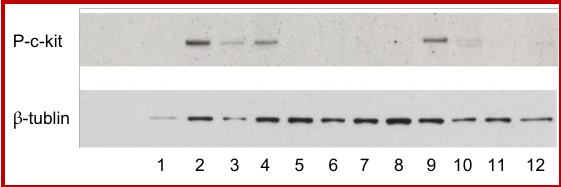
Figure 2: Imatinib inhibits the SCF induced c-kit phosphoryla- tion in NHEM (western blot assay). 1: Control group; 2:10 ng/ mL SCF; 3:20 ng/mL SCF; 4.5 ng/mL SCF; 5. 0.1 µM imatinib; 6.1.0 µM imatinib; 7.5.0 µM imatinib; 8. 10.0 µM imatinib; 9.5 ng/mL SCF + 0.1 µM imatinib; 10. 50 ng/mL SCF + 1.0 µM imatinib; 11.5 ng/mL SCF + 5.0 µM imatinib; 12.5 ng/mL SCF